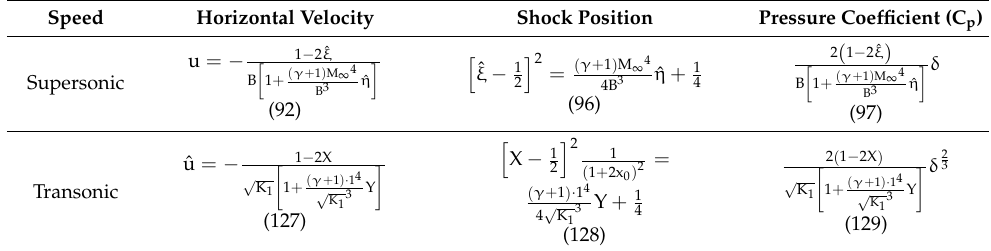
Table 2. Far field results according to different speeds for a parabolic airfoil F(x) = x(1 − x). Formulae are used in their stretched far field